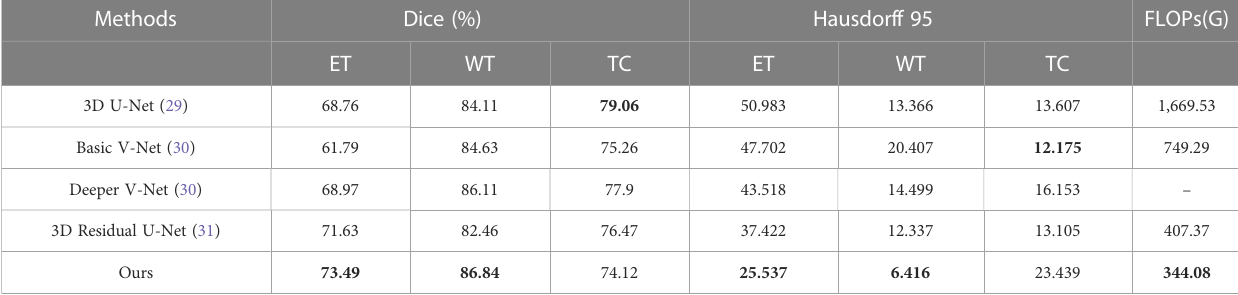
TABLE 2 Comparative experimental results on BraTS 2020. Methods